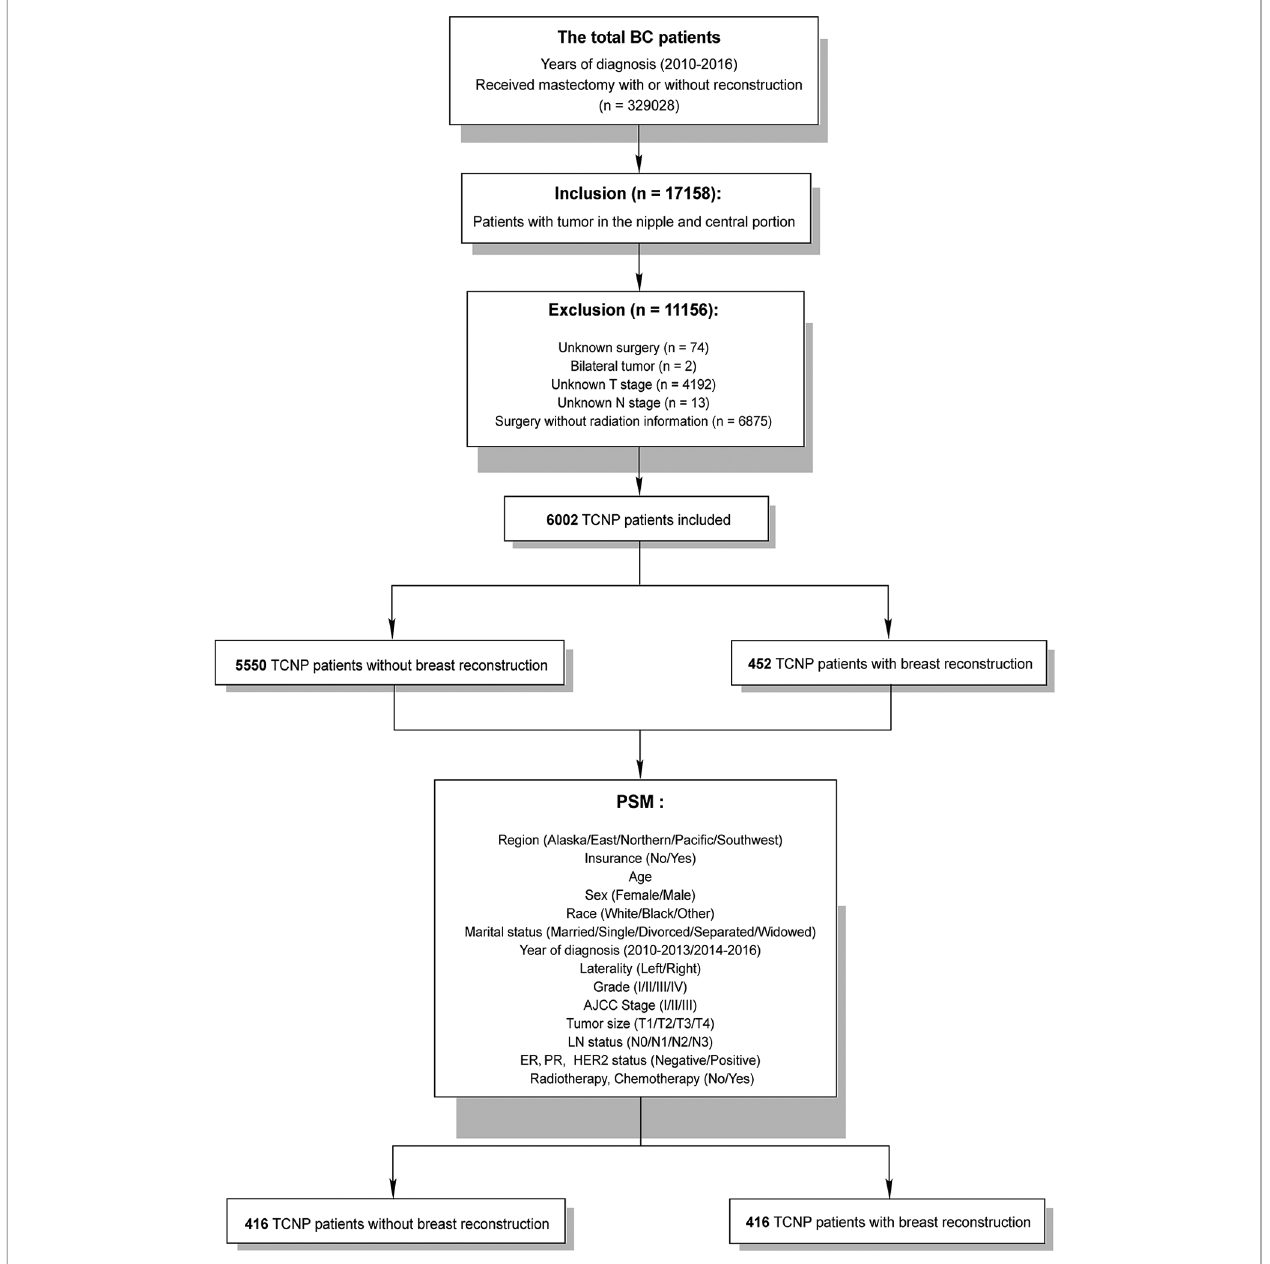
FIGURE 1 | Flow diagram of inclusion criteria and exclusion criteria for analyzing reconstruction in fl uences on tumors in the central and nipple portion